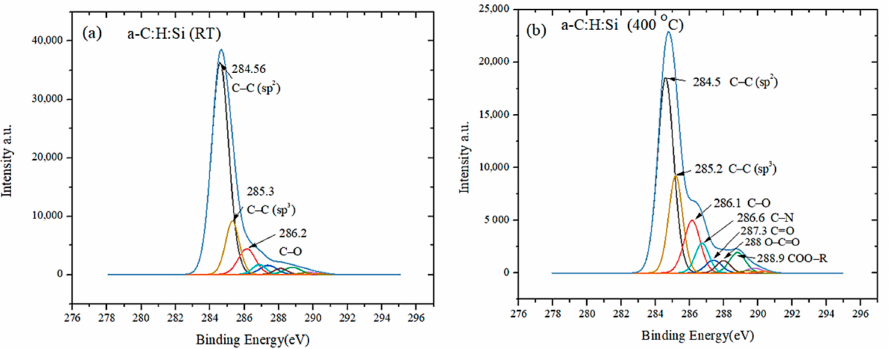
Figure 8. C1s XPS spectra taken on the a-C:H:Si coating native surface at ( a ) RT and ( b ) 400 °C.